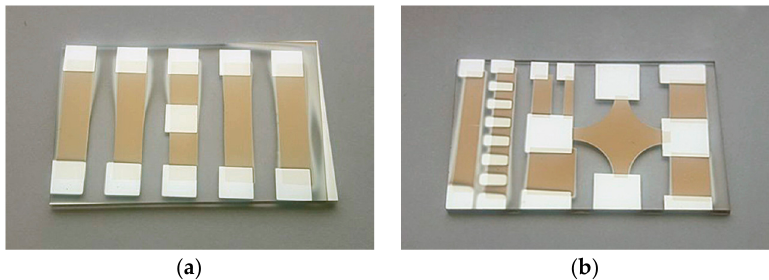
Figure 2. Ge–Au/NiCrSi/Ag test structures: ( a ) structures for thermoelectric measurements (five separated thermocouples deposited onto one substrate); ( b ) structure for electrical measurements (van der Pauw method).